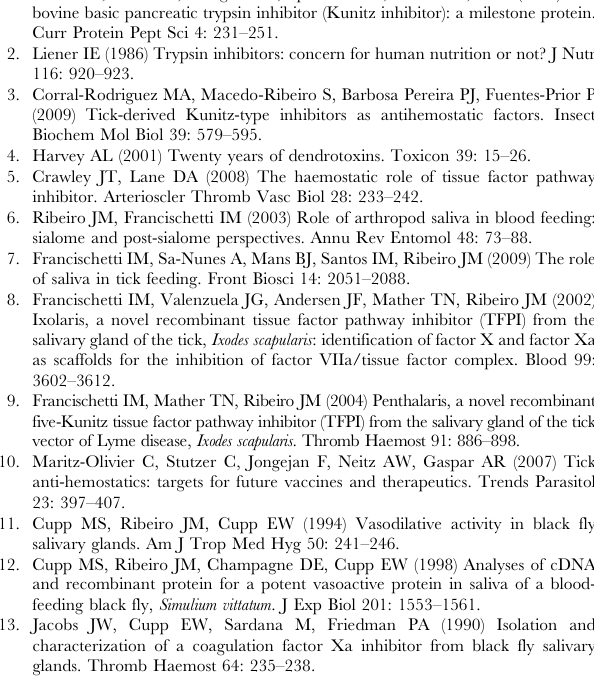
identical for all samples. Figure S2 Determination of rSimukunin IC 50 values for selected serine proteinases. Enzymes, at the concentrations given in Table 1, were incubated with the indicated concentration of rSimukunin for 5 min at 30 u C, followed by addition of substrate (250 m M final concentration). The amount of enzyme used in the assays was the lowest possible to give a linear substrate hydrolysis rate in the assays (r 2 . 0.95). Substrate hydrolysis was followed in a Tecan Infinite M200 96-well plate fluorescence reader ( Tecan group Ltd, Switzerland) using 365 nm excitation and 450 nm emission